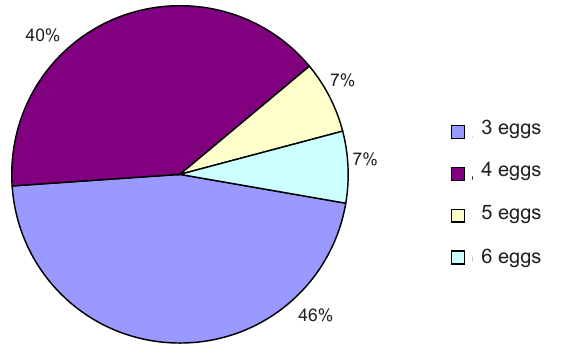
Figure 1. Clutch size in Small Bee-eater (N =